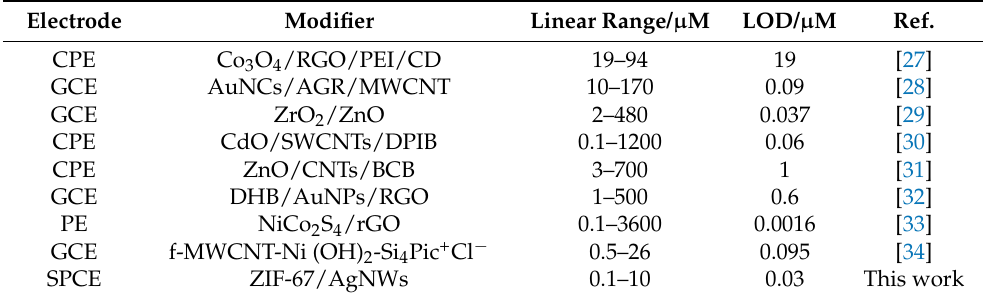
Table 2. Comparison of different methods for FA